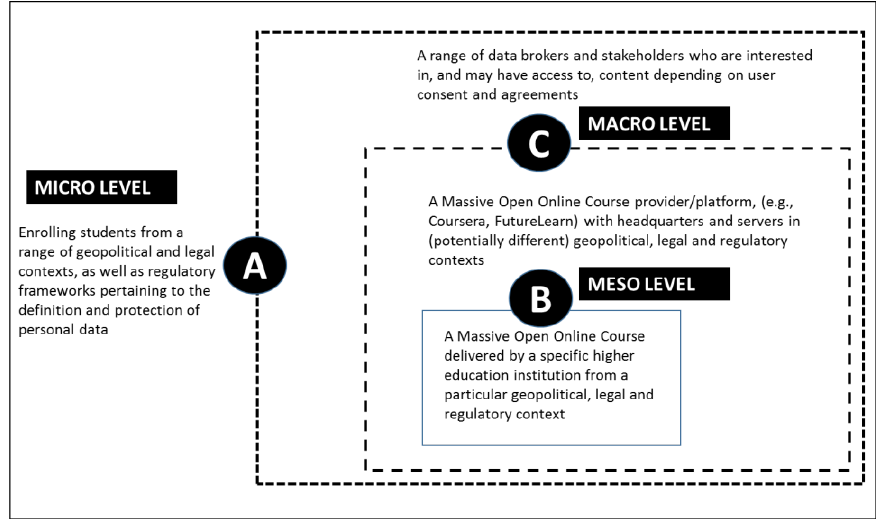
Figure 1. Mapping the micro, meso, and macro-levels of consent in MOOCs. At the micro level (Point A), the issue of consent pertains specifically to the collection, analysis, and use of student data in learning